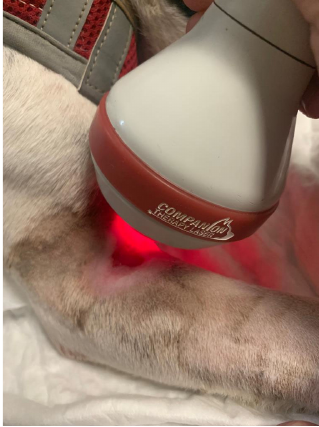
Figure 5. Class IV laser therapy performed on an elbow pressure sore of a dog.